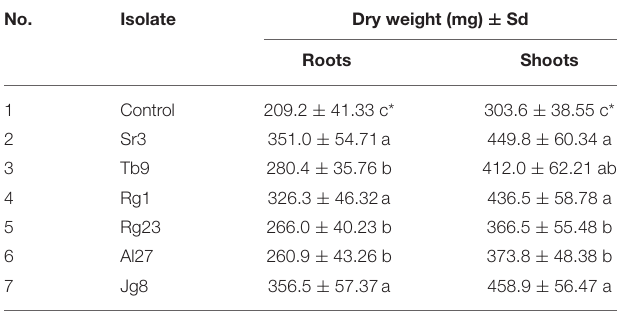
TABLE 4 | Effect of rhizobacteria to the dry weight of roots and shoots of corn cultivar Pertiwi at the age of 7 days. No.